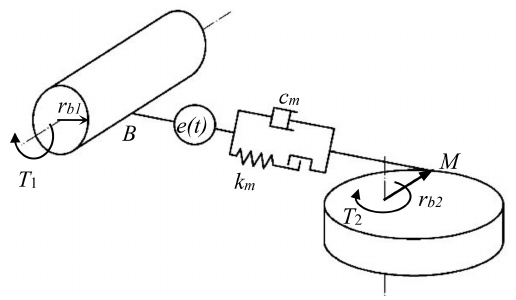
Figure 5. Dynamic model of the NFG